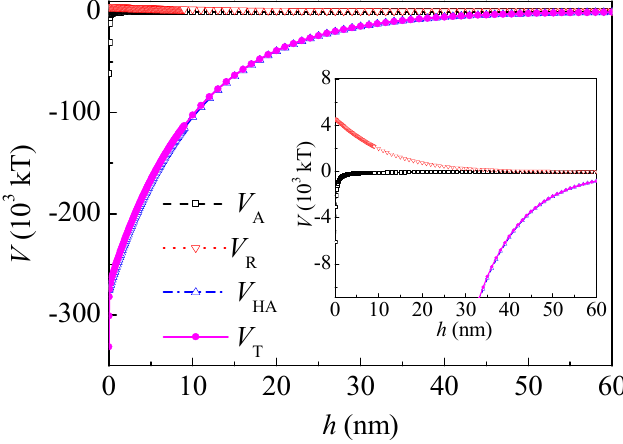
Figure 3. Potential energy between coal particles.